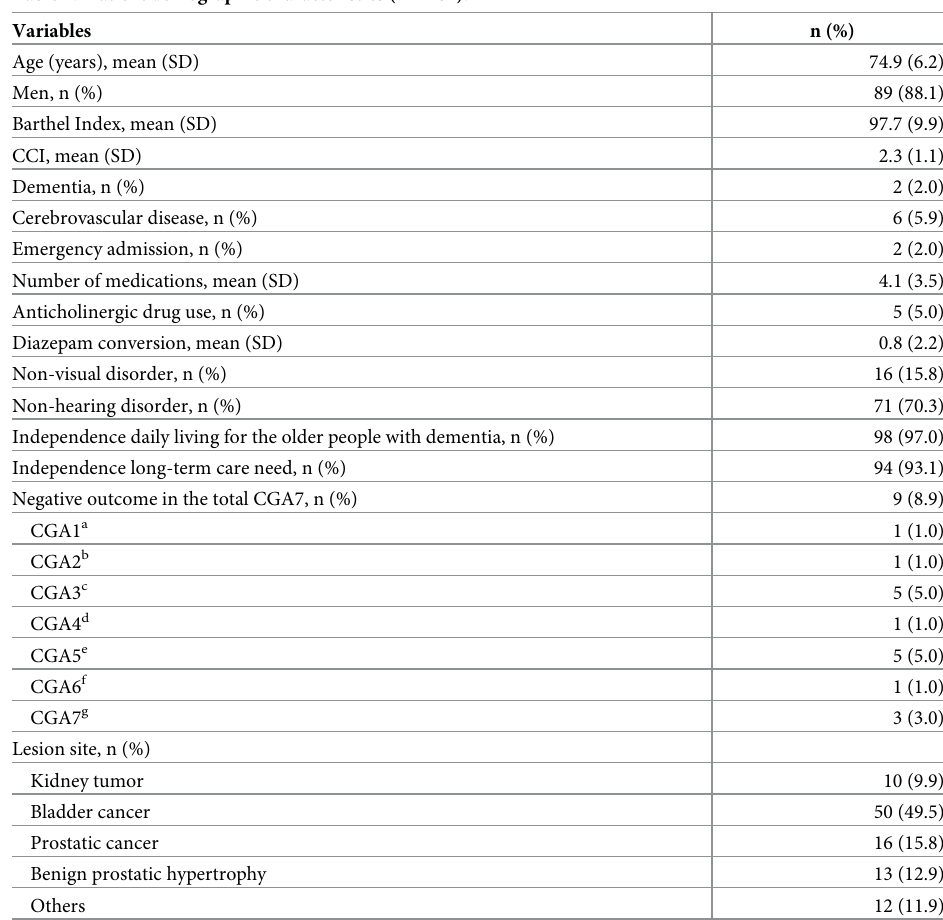
Table 1. Patient demographic characteristics (n =